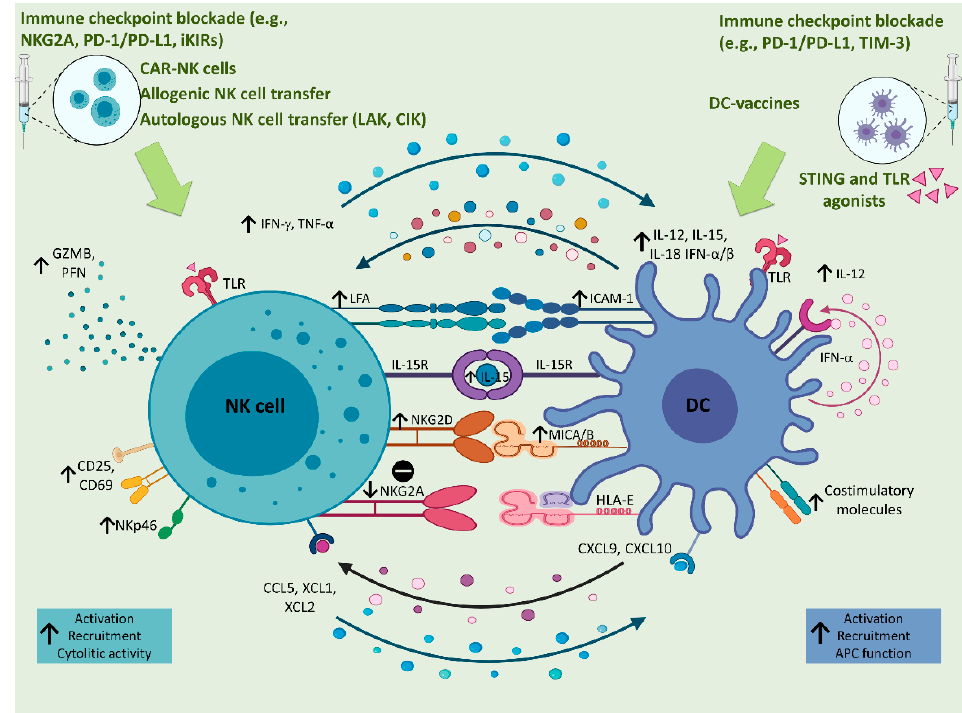
Figure 3. Implications of NK–DC crosstalk in liver cancer immunotherapy. Several immunotherapeutic approaches based on the administration of CAR-NK cells, allogenic or autologous NK cells or DC-vaccines are used in cancer patients to activate innate immune responses against tumor cells. The NK cell activation could also be reached through the administration of TLR agonists, like IQ and GDQ, which are, respectively, TLR7 and TLR7/8 agonists. NK cell activation on one hand leads to DC maturation, and on the other hand it is enhanced by the interaction with DCs, which in turn are activated by TLR agonists or STING. This bilateral activation involves the upregulation of CD69, CD25, NKp46, NKG2D, and the release of lytic enzymes (e.g., GZMB and PFN) by NK cells. On the other hand, activated DCs undergo upregulation of costimulatory molecules, NKG2D ligands (e.g., MICA/B) and an increased release of IFN- α , which in a positive loop, also contributes to the production of IL-12 that activates NK cells to produce high levels of IFN- γ and TNF- α . In addition, IL-15 and IL-18 sustain NK cell survival and activation that are also favored by the direct contact between NK cells and DCs through the interaction between NKG2D and its ligands, and LFA and ICAM-1, on NK cell and DC surface, respectively. Moreover, the reciprocal recruitment of both cellular populations is supported by the production of CXCL9 and CXCL10 by DCs and CCL5, XCL1, and XCL2 by NK cells. Other immunotherapeutic approaches, aimed at blocking inhibitory receptors, like the NKG2A, iKIRs, and the PD-1/PD-L1 axis, favor the activation of NK cells, consequently allowing DC maturation and activation, which could be also enhanced by the administration of immune checkpoint inhibitors against PD-1/PD-L1 or TIM-3. [CAR-NK cells, Chimeric Antigen Receptor natural killer cells; CCL5, C-C Motif Chemokine Ligand 5; CXCL10, Chemokine (C-X-C motif) ligand 10; CXCL9, Chemokine (C-X-C motif) ligand 9; DCs, dendritic cells; GDQ, Gardiquimod; GZMB, granzyme B; HLA-E, Major Histocompatibility Complex, Class I, E; IFN- α , interferon α ; IFN- β , interferon β ; IFN- γ , interferon γ ; IL-12, interleukin 12; IL-15, interleukin 15; IL-15R, interleukin 15 receptor; IL-18, interleukin 18; iKIRs, inhibitory Killer-cell immunoglobulin-like receptors; MICA/B, MHC class-I-related protein A/B; IQ, Imiquimod; NK cells, natural killer cells; PD-1, programmed cell death protein 1; PD-L1, programmed death-ligand 1; PFN, perforin; STING, stimulator of interferon genes; TIM-3, T-cell immunoglobulin domain and mucin domain 3; TLR, toll-like receptor; TNF- α , tumor necrosis factor α ; XCL1, Chemokine (C motif) ligand 1; XCL2, Chemokine (C motif) ligand 2; and XCR1, X-C Motif Chemokine Receptor 1]. Created with BioRender.com (accessed on 16 March